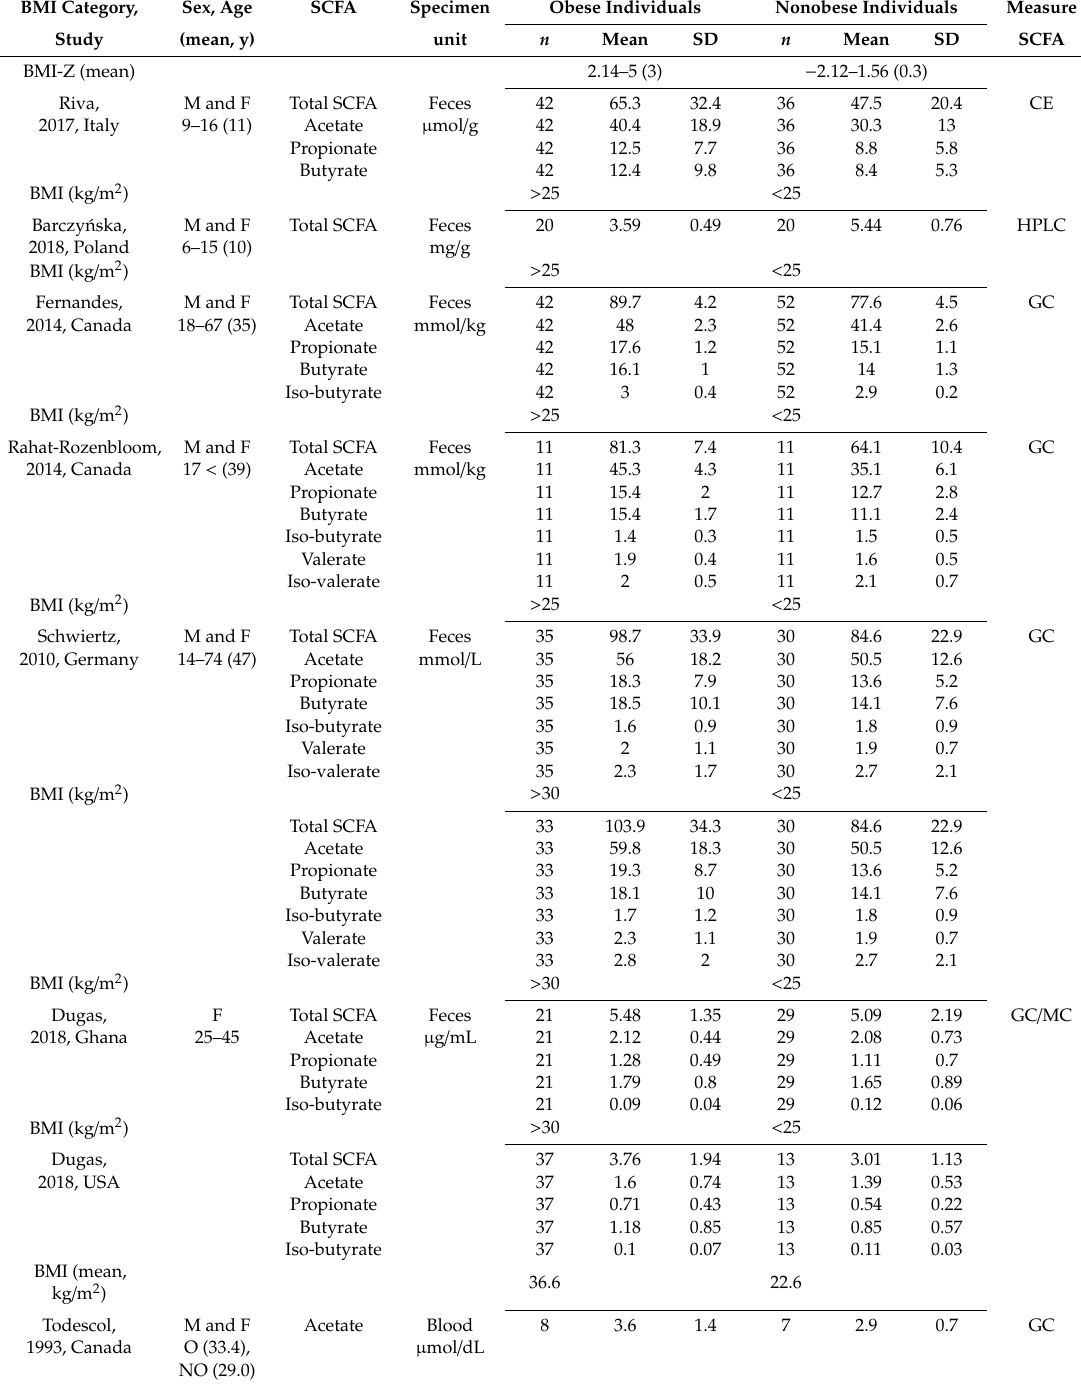
Table 1. Characteristics of studies included in the analysis of short chain fatty acid (SCFA)